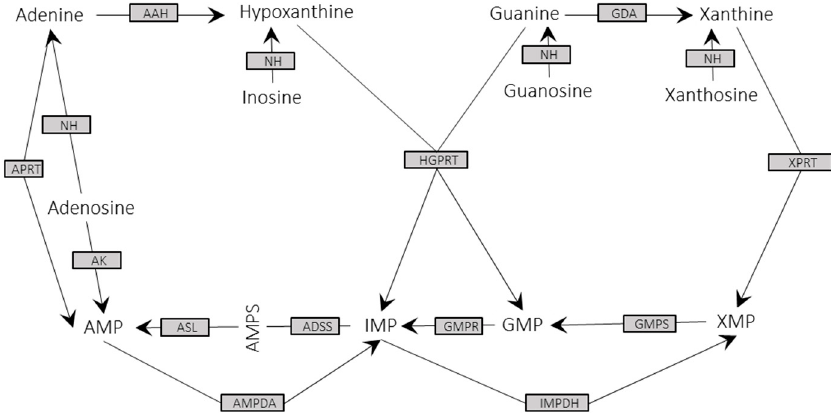
Figure 4. Enzymesfromthepurinesalvagecyclesidentifiedinthe L.infantum experimentalproteome. Allthe Figure 4. Enzymes from the purine salvage cycles identified in the L. infantum experimental proteome. enzymes(greysquares)thatarerequiredtocompletethepathwaywereidentifiedinthisstudy. APRT:adenine All the enzymes (grey squares) that are required to complete the pathway were identified in this phosphoribosyltransferase (LINF_130016900); NH: nucleoside hydrolase (LINF_180021400); AK: adenosine study. APRT: adenine phosphoribosyltransferase (LINF_130016900); NH: nucleoside hydrolase kinase (LINF_300014400); AAH: adenine aminohydrolase (LINF 350026800); ASL: adenylsuccinate lyase (LINF 040009600); AMPDA: AMP deaminase (LINF 130014700); ADSS: adenylosuccinate synthetase (LINF 130016900); GMPR: GMP reductase (LINF 170014800); GMPS: GMP synthase (LINF 220006100); HGPRT: hypoxanthine-guanine phosphoribosyltransferase (LINF 210014900); GDA: guanine deaminase (LINF 290014000); IMPDH: inosine monophosphate dehydrogenase (LINF 190022000); and XPRT: xanthine phosphoribosyltransferase (LINF 210015000). The cycle was depicted according to Boitz et al. [58]. Table 4. Enzymesinvolvedindenovopyrimidinebiosynthesisidentifiedin L.infantum promastigoteproteome. Gene ID Unique Peptides Description Table 4. Enzymes involved in de novo pyrimidine biosynthesis identified in L. infantum promastigote proteome . LINF_060011200